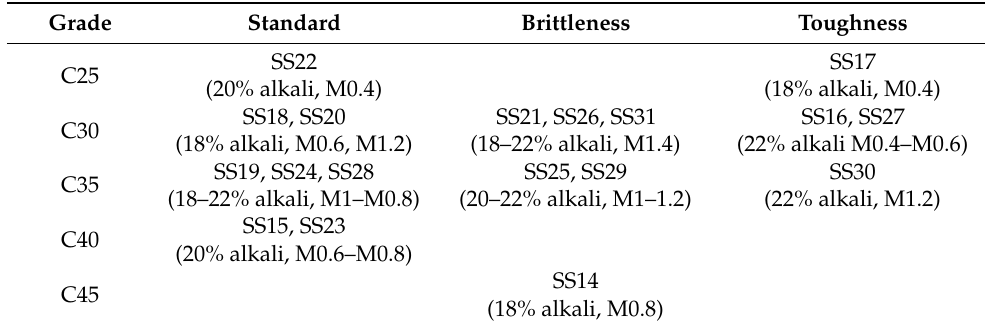
Figure 11. The relationship between the dosage of SS activator and the flexural strength. ( a ) 3 days, ( b ) 7 days, ( c ) 28 days. Table 9. Comparison of geopolymer strength and